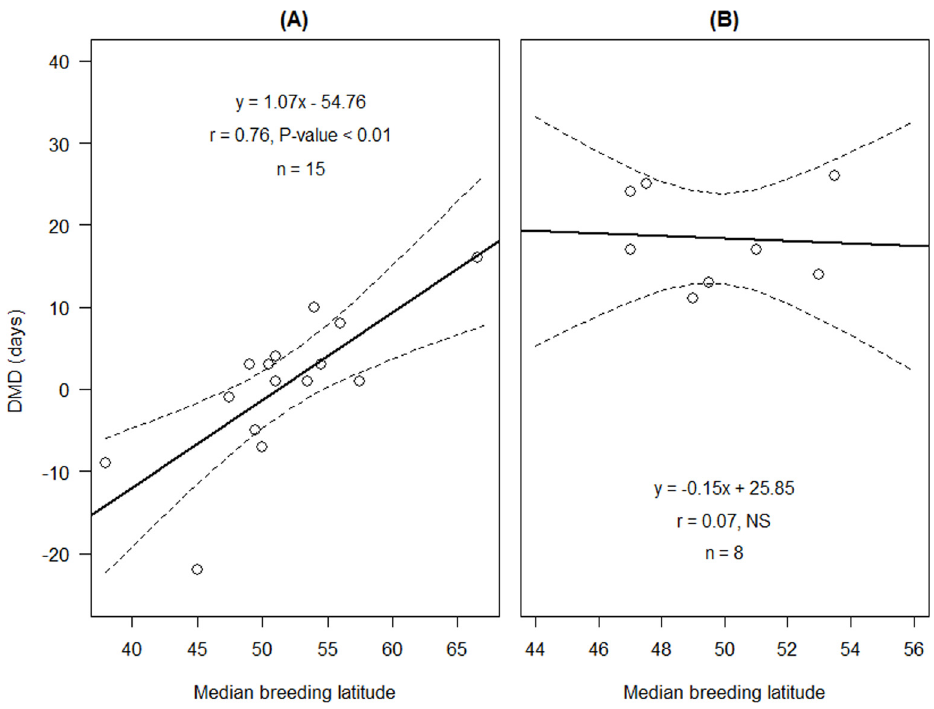
Fig 4. The difference in median migration date (DMD), through Israel, between juveniles and adults (days) in relation to breeding latitude and moult strategy, summer (A) or winter (B), in 23 passerines species. The difference between slopes is significant (P < 0.05); dashed curves represent 95% regression confidence intervals.